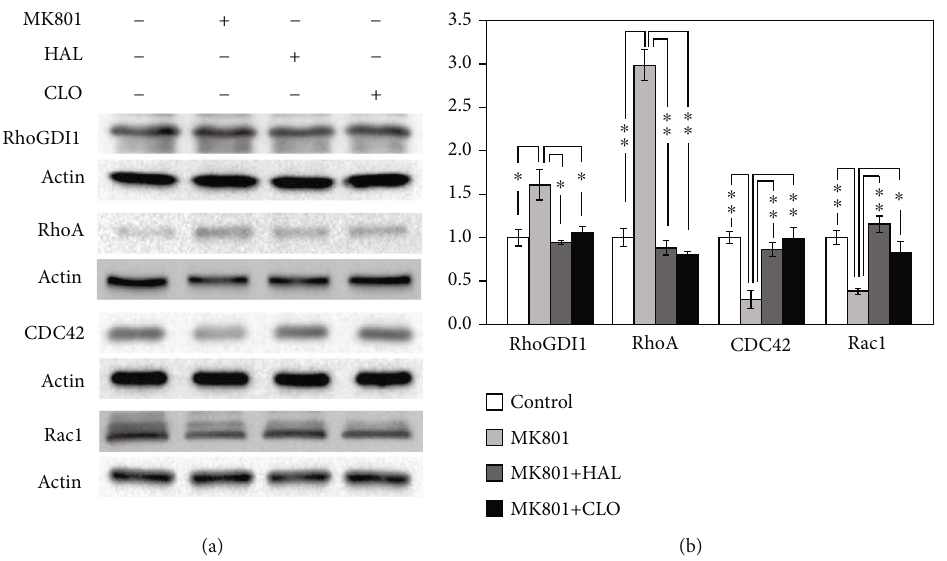
Figure 1: Haloperidol (HAL) and clozapine (CLO) reverse the MK801-induced Rho family protein regulation. (a) Western blot revealing APD-induced changes in the expression of the RhoGDI, RhoA, CDC42, and Rac1 proteins in B35 cells. (b) Protein expression was quanti fi ed and normalized to beta-actin, and the relative expression of each protein shown in the bar chart was calculated from triplicate western blot data that were obtained from three di ff erent batches of APD-treated cells and analyzed using ANOVA followed by Dunnett ’ s test ( ∗ p value < 0.05; ∗∗ p value < 0.01).